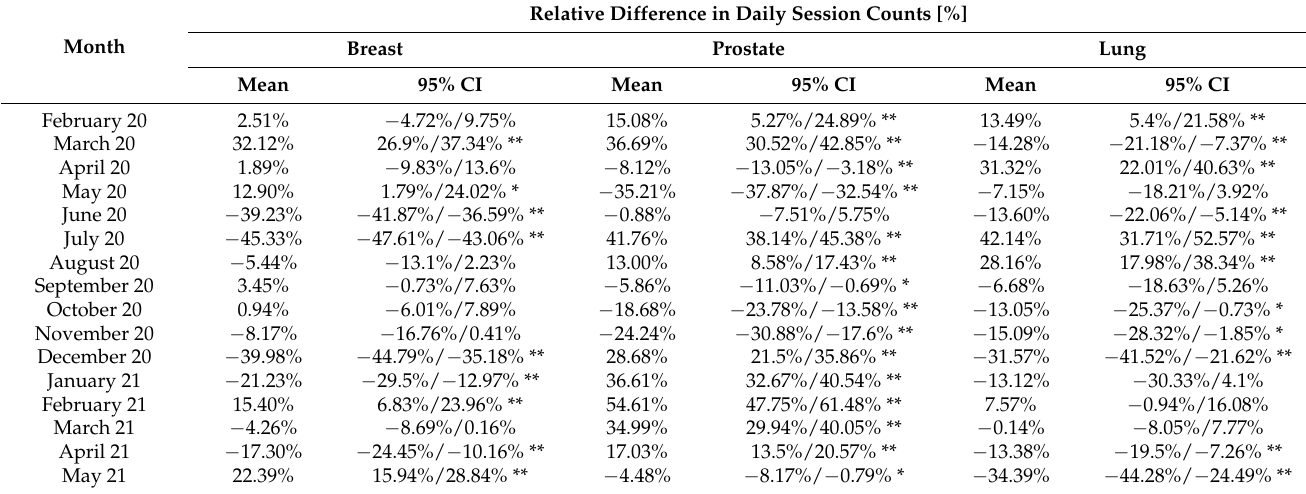
Table 3. Relative difference of breast, prostate and lung cancer RT session count during the COVID-19 epidemic in comparison to the pre-pandemic reference period.